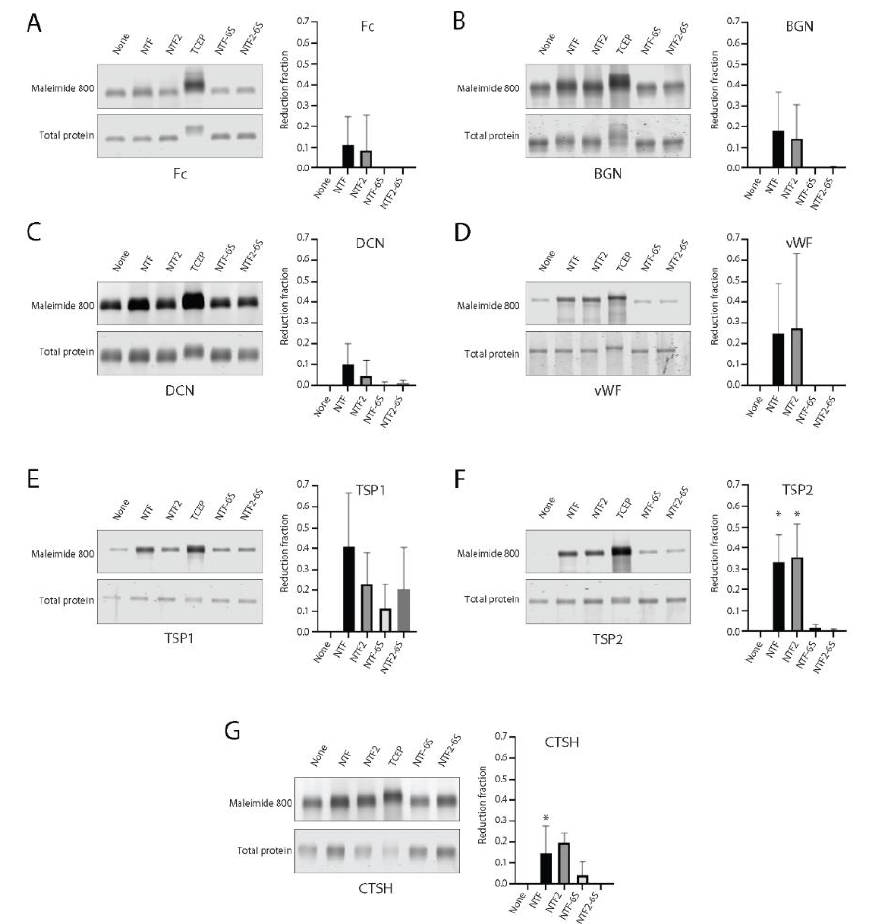
Figure 4. Vascular matrix proteins trans-reduction by NTF2. ( A – G ) Fc or vascular matrix proteins, BGN, DCN, vWF, TSP1, TSP2, CTSH, or HTRA1, were treated with NTF, NTF2, TCEP, NTF-6S or NTF2-6S. Fc was used as a fusion partner for NOTCH3 fragments in Figures 1–3, and as such, was also included for comparison. Maleimide dye (10-fold molar excess) was used for labeling of reduced proteins and detected by gel scanning ( upper panel) . Simply Blue total protein stain was used as a protein loading control for each group ( lower panel ). The ratio of maleimide dye labeling to Simply Blue labeling was calculated; the untreated ratio was subtracted from treatment ratios and normalized to the ratio after TCEP treatment to derive adjusted reduction fractions of matrix proteins trans-reduced by NTF and NTF2 shown in the y -axis of plots. Only TSP2 (with NTF, NTF2) and CTSH (with NTF2) were significantly reduced (compared to respective cysteine-free peptide controls; * p < 0.5). We did not display HTRA1 data, because TCEP-reduced HTRA1 demonstrated lower maleimide dye signal than the other groups, for unclear reasons. Reaction volumes were 5 µ L followed by addition of 10 µ L labeling mix. All experiments were performed at least three times and included in the final quantified